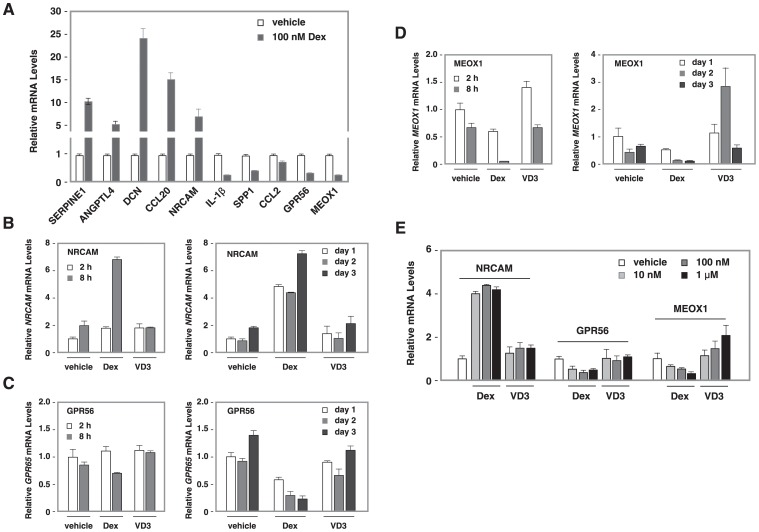
The effects of Dex on NRCAM, GPR56 and MEOX1 mRNA accumulation.(A). Top five genes that were up-regulated and top five genes that were down-regulated by Dex in HPCs. In vitro differentiation of HPCs, total RNA isolation and qRT-PCR were described in ‘Materials and Methods. The relative mRNA levels of [+Dex]/[-Dex] are shown for each gene. (B–D). A time-course experiment of Dex’s effects on NRACM, GPR56 and MEOX1 mRNA levels. HPCs were induced to differentiation for two days followed by hormone treatment. Cells were harvested 2, 8, 24, 48 and 72 h after treatment, total RNA isolated and qRT-PCR performed. The relative mRNA levels of NRCAM (B), GPR56 (C) and MEOX1 (D) are normalized by GAPDH mRNA and the value at 2 h (left) or day 1 (right) is set at 1. (E) Dosage-dependent responses of NRCAM, GPR56 and MEOX1 mRNAs to Dex treatment. Differentiating HPCs were treated with vehicle, 10 nM, 100 nM or 1 µM of Dex or VD3, cell harvested 4 h after treatment, total RNA prepared and subjected to qRT-PCR.